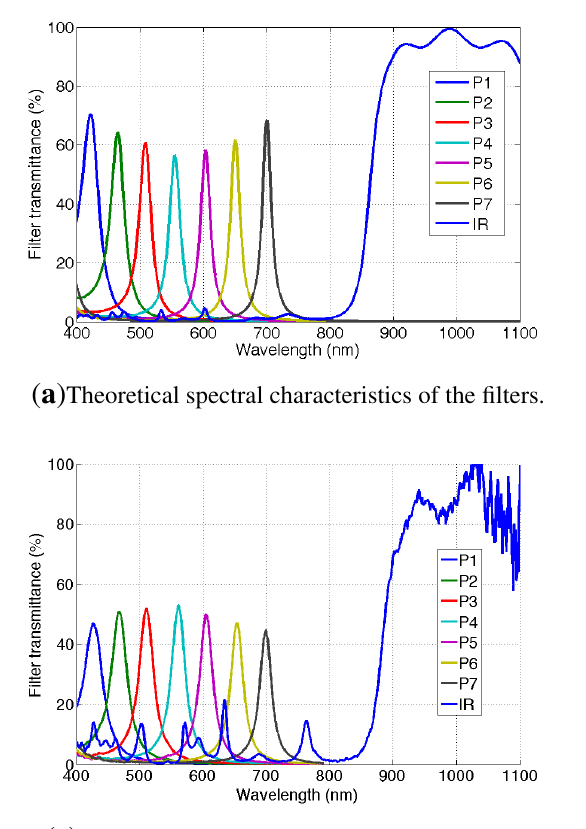
Figure 10. ( a ) Spectral characteristics of the filters. Channels { P 1 − P 7; IR } are labeled following the scheme of Figure 11; ( b ) Simulation of the relative actual response of the multispectral imaging system (sensor associated with filters). Measured data ( c ) and ( d ) highlight some spectral differences compared to simulation.